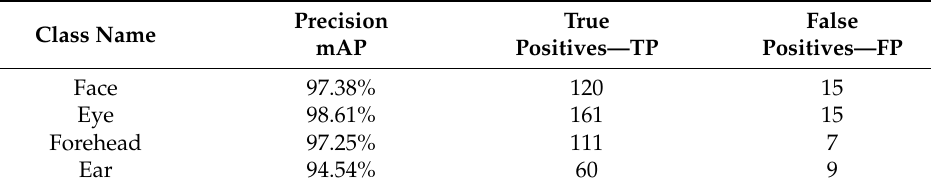
Table 1. Performance for each ROI during validation.